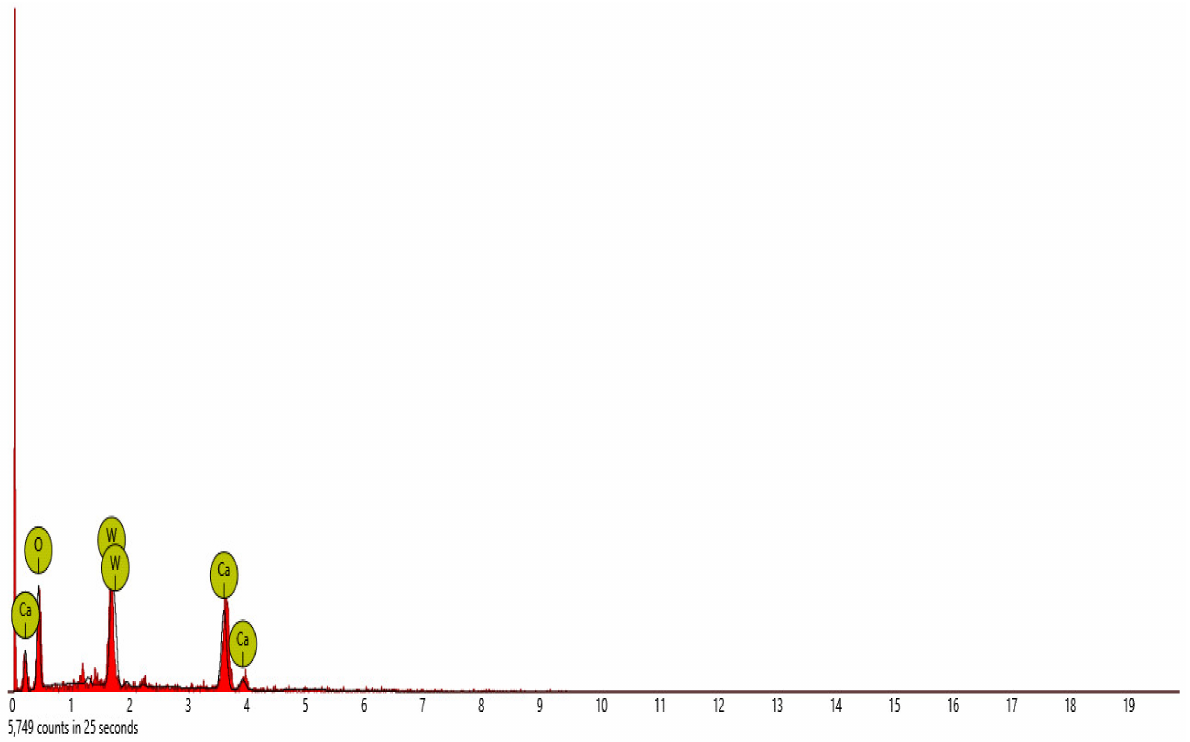
Figure 19. Bar charts illustration of the weight and atomic quantifications of the element discovered from the EDS spectra of pervious concrete spot 2 sample Y 4